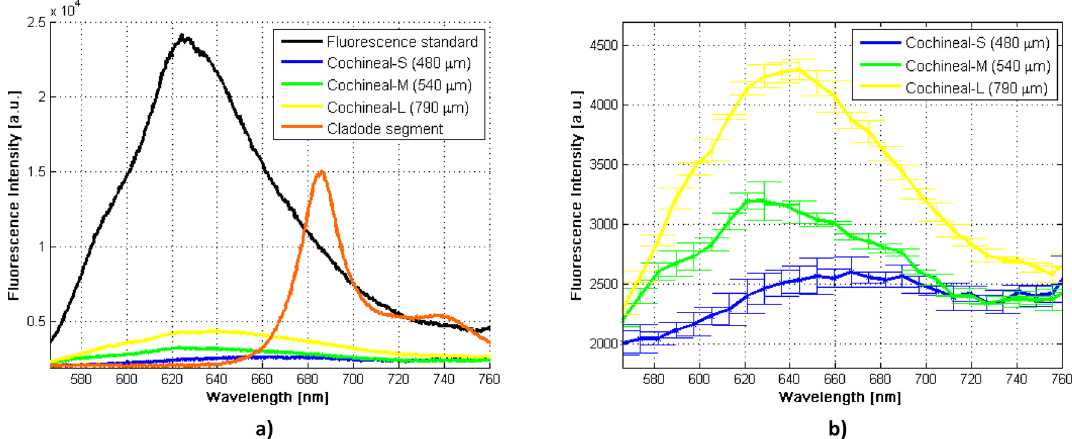
(small, medium and large) and in-vivo cladode segment fluorescence. ( b ) In-vivo fluorescence spectra of wild cochineals of different